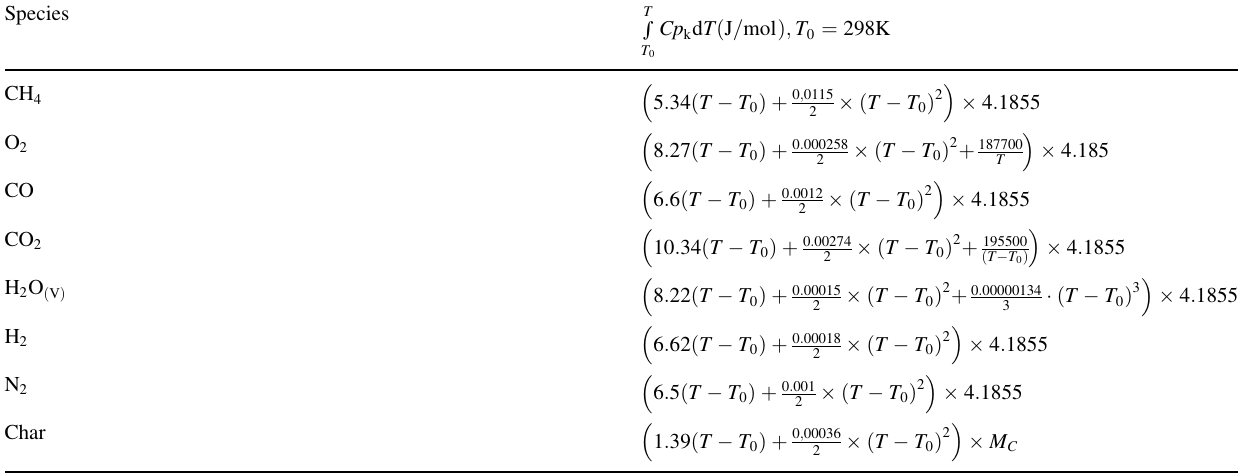
Table 13 Expressions of integral heat capacity at constant pressure of gaseous species and the char depending on the temperature between T 0 = 298 K and T (Lu et al. 2018) Species